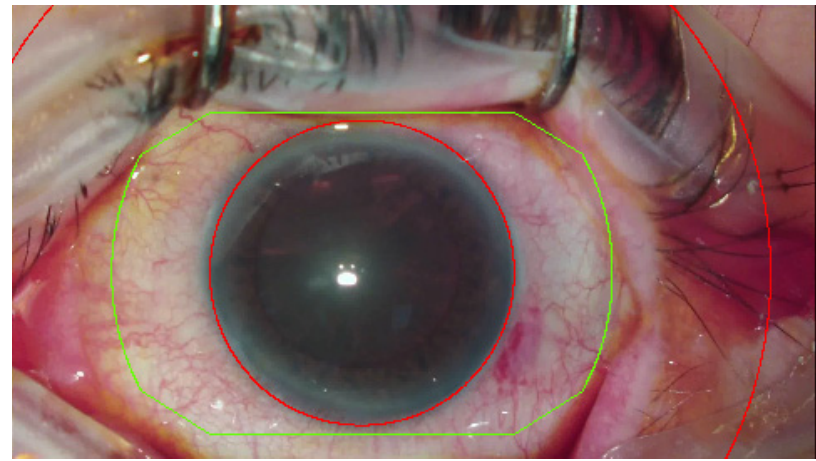
Figure 2. Region of interest of the INTEGRA system. Area indited to analyze is outside red circle and limited by green line.